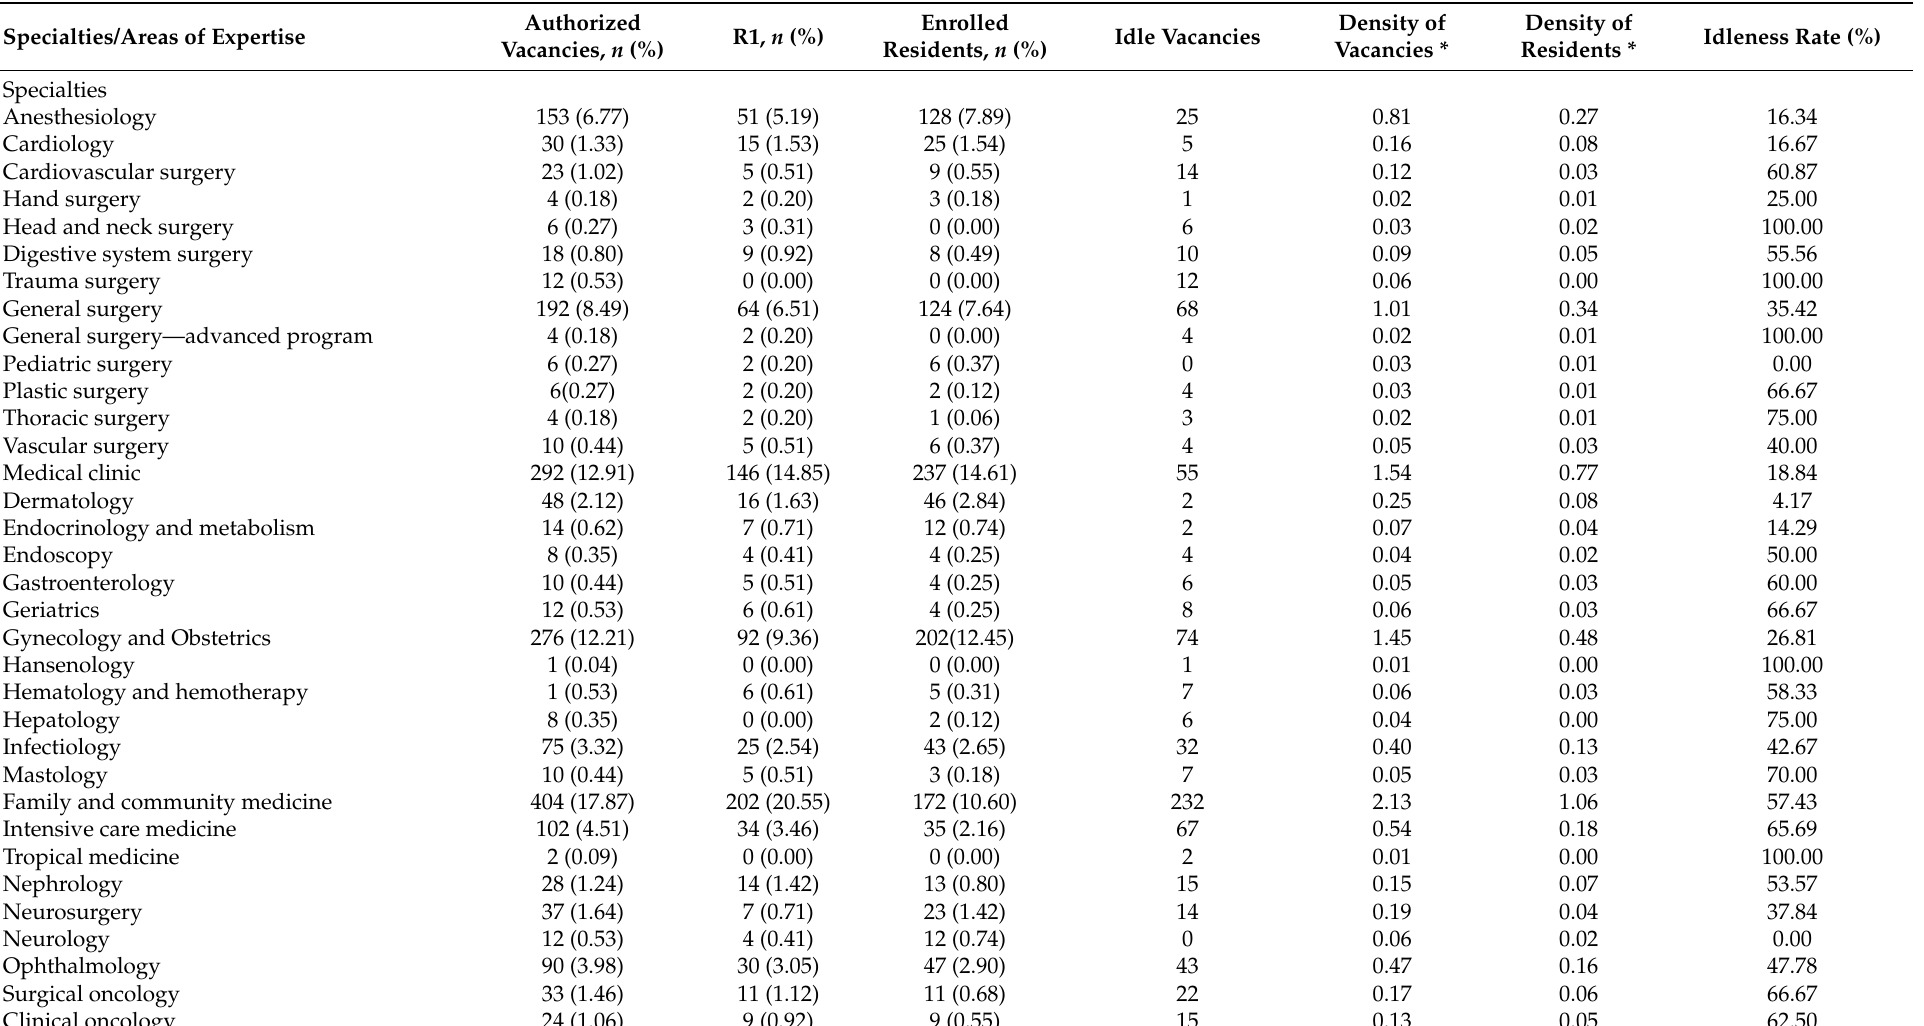
Table 3. Overview of indicators of medical residency programs based on specialty or areas of expertise. North region, Brazil,